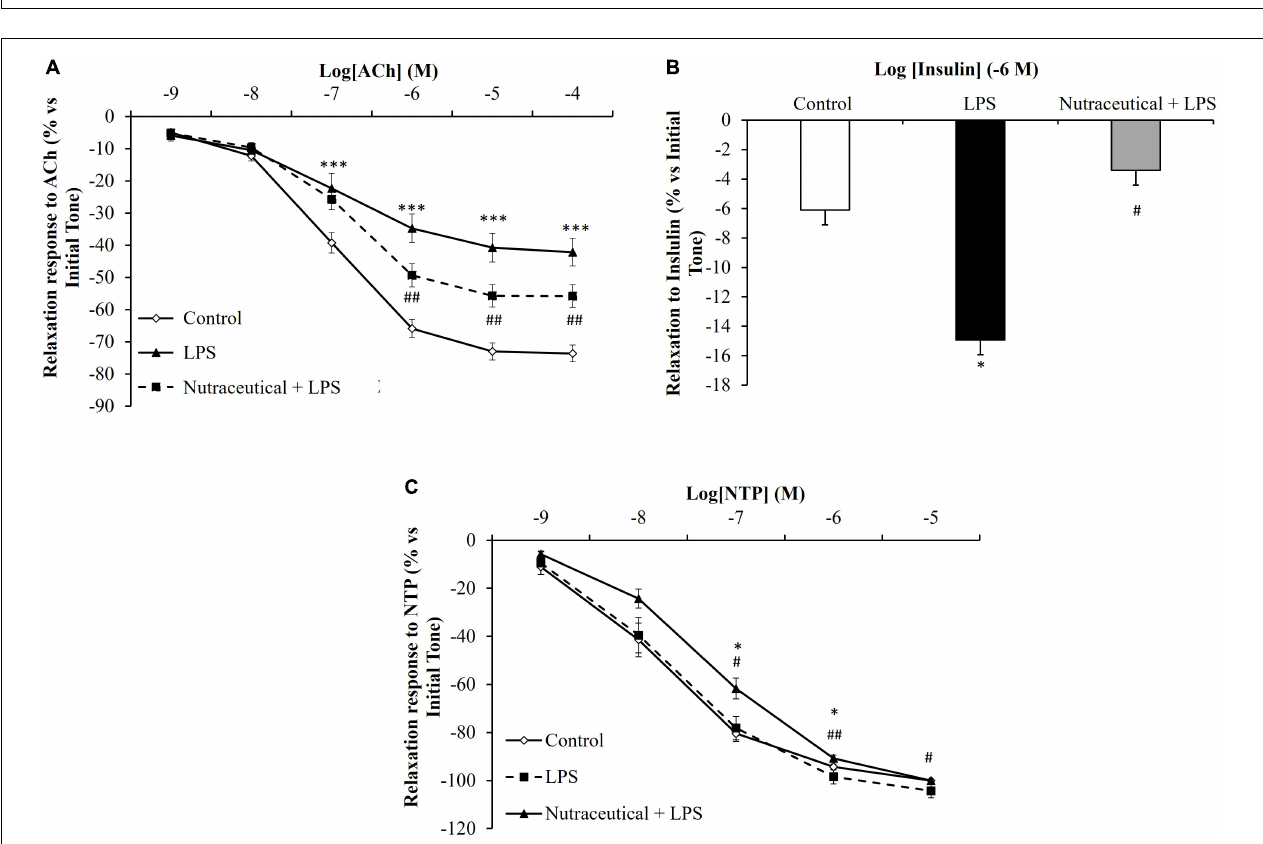
FIGURE 3 | Contraction response of abdominal aortic segments to norepinephrine (A) and to angiotensin-II (B) of rats treated with vehicle, LPS or LPS + Nutraceutical. Values are represented as mean ± SEM. ∗ p < 0.05 vs. Control; ∗∗ p < 0.01 vs. Control; ∗∗∗ p < 0.001 vs. Control; # p < 0.05 vs. LPS.